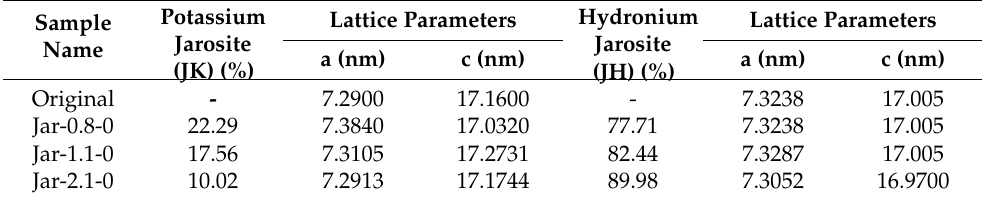
Table 3. Rietveld analysis for the synthesis of jarosite and effect of pH values (0.8, 1.1, and